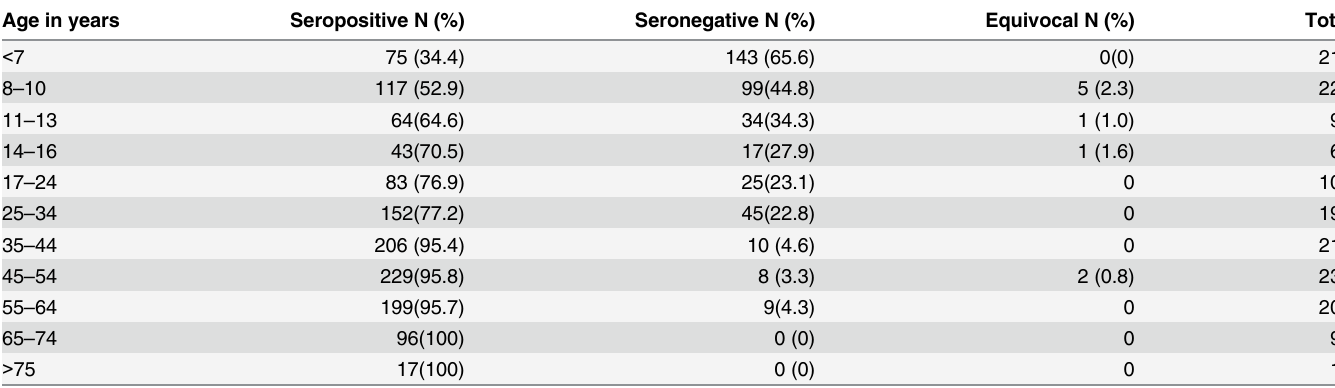
Table 1. Age stratified detection of anti-DENV antibodies.